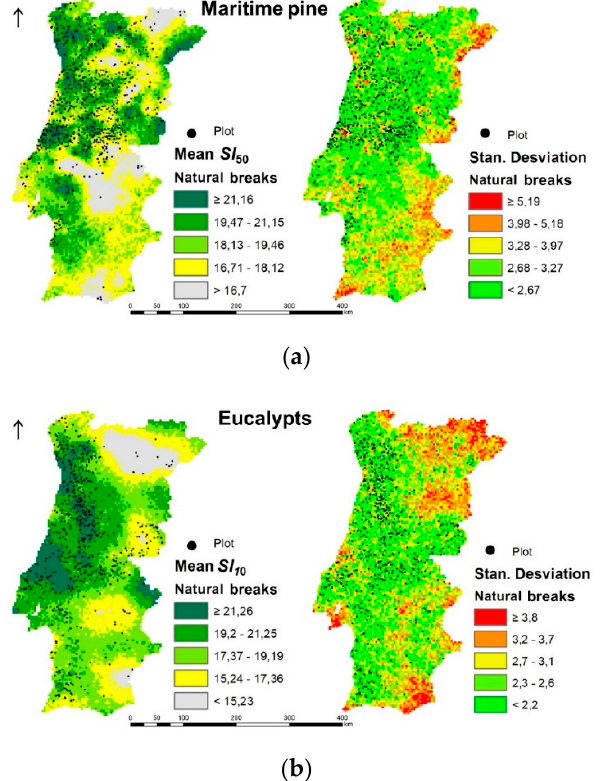
Figure 8. Current climate productivity maps—Site index: ( a ) Maritime pine— SI 50 mean image (MI) and standard deviation ( SU ); ( b ) Eucalypts— SI 10 mean image ( MI ) and standard deviation ( SU ). Legend: SI 50 — hdom (m) at the age of 50 years; SI 10 — hdom (m) at the age of 10 years; MI —mean image of 100 computed scenarios through SGS (Sequential Gaussian Simulation); SU —spatial uncertainty (back-transformed standard deviation).